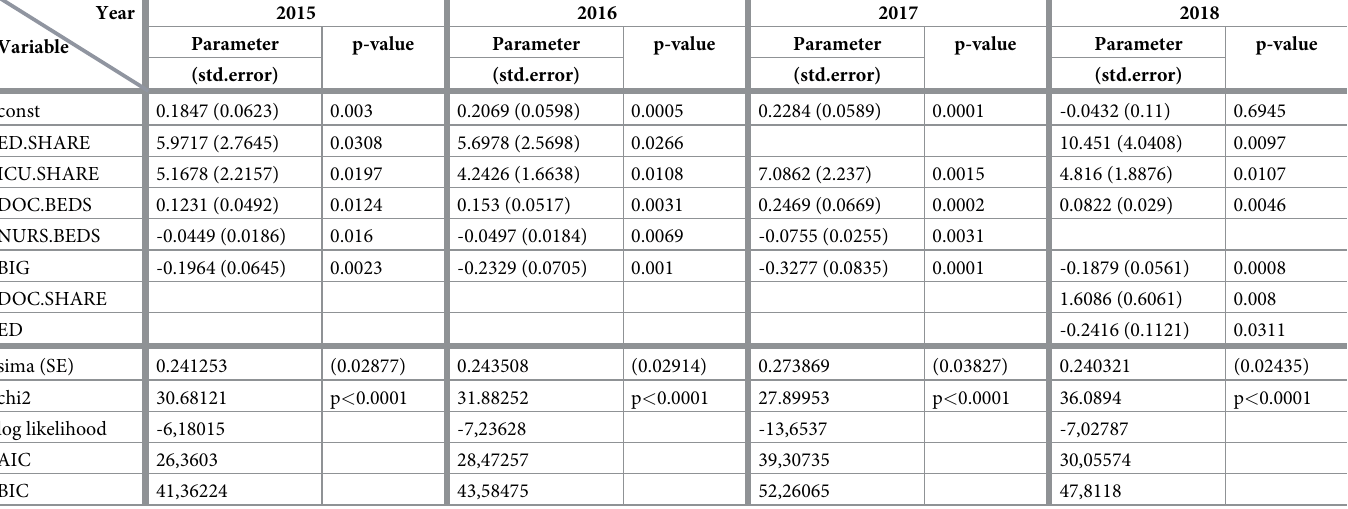
Table 15. Results of Tobit regression of inefficiency on hospital characteristics ( traditional approach).